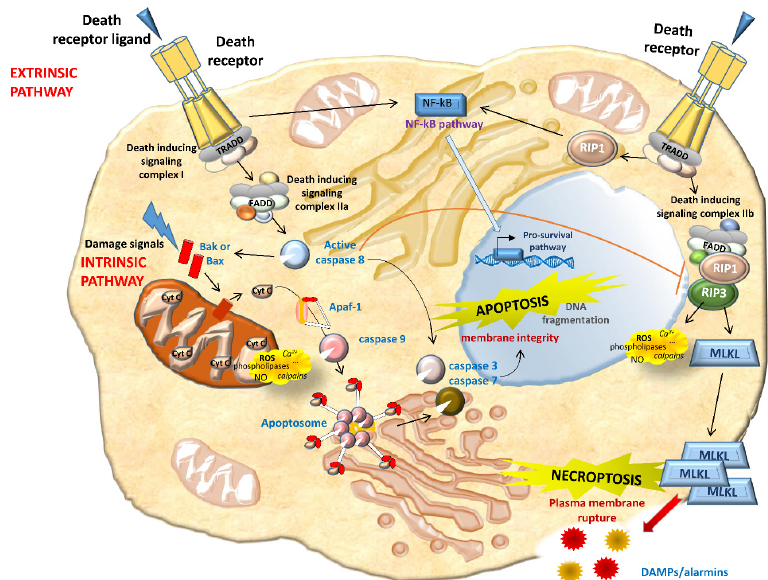
Figure 2. Overview of key molecular pathways of apoptosis and necroptosis. Apoptosis can start via intrinsic pathways (perturbation of intracellular homeostasis) or extrinsic pathways (death receptor binding). In the former case, cell stress leads directly (or via mediators, such as Bax and Bak) to mitochondrial outer membrane permeabilization, resulting in the release of apoptogenic factors, including Cytochrome c , which binds Apaf-1 to stimulate caspase-9 via apoptosomes. Bcl-2-related proteins induce apoptosis (e.g., Bax) or protect against it (e.g., Bcl-2). As for the extrinsic pathway, death receptor binding guides the recruitment of adapter proteins such as TRADD (TNFR-associated death domain), forming complex I. While complex I promotes cell survival via NF- к B activation, its